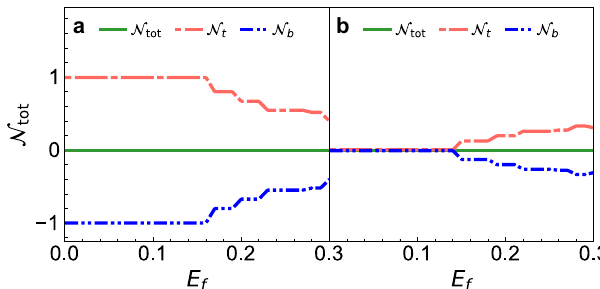
Fig. 2 Non-commutative Chern number N in the Majorana basis as a function of Fermi energy E f . a The total Chern number of a bare axion insulator is N tot ¼ 0 but the local Chern markers are integer-quantized as N ¼ 1 and N ¼ (cid:2) 1, revealing the topological nontriviality of the top and t b bottom surfaces. Here, m = 0.2, Δ = 0, and L z = 10. b Top and bottom surfaces can be driven into the N t = b ¼ 0 phase in proximity with superconductors. Here, m = 0.2, Δ = 0.4, and L z =